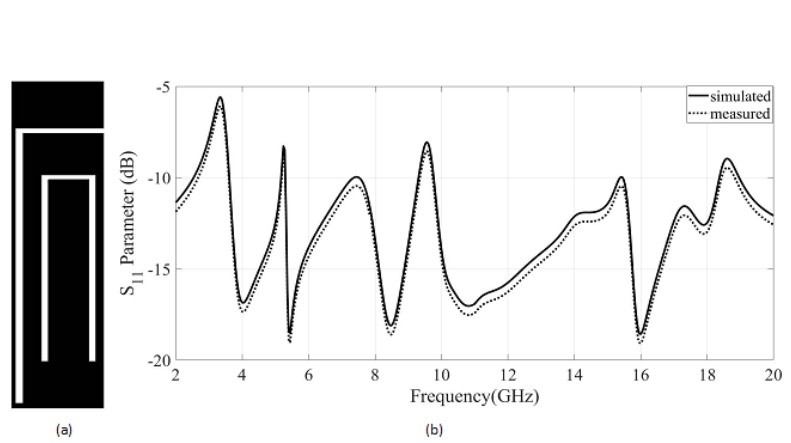
Figure 5. ( a ) Geometry of the inverted L-shaped slit and U-shaped slot; ( b ) S 11 parameter of combine L = 11 mm and U u = 8 mm along with the creation of another rejection band at X-band for satellite communication.